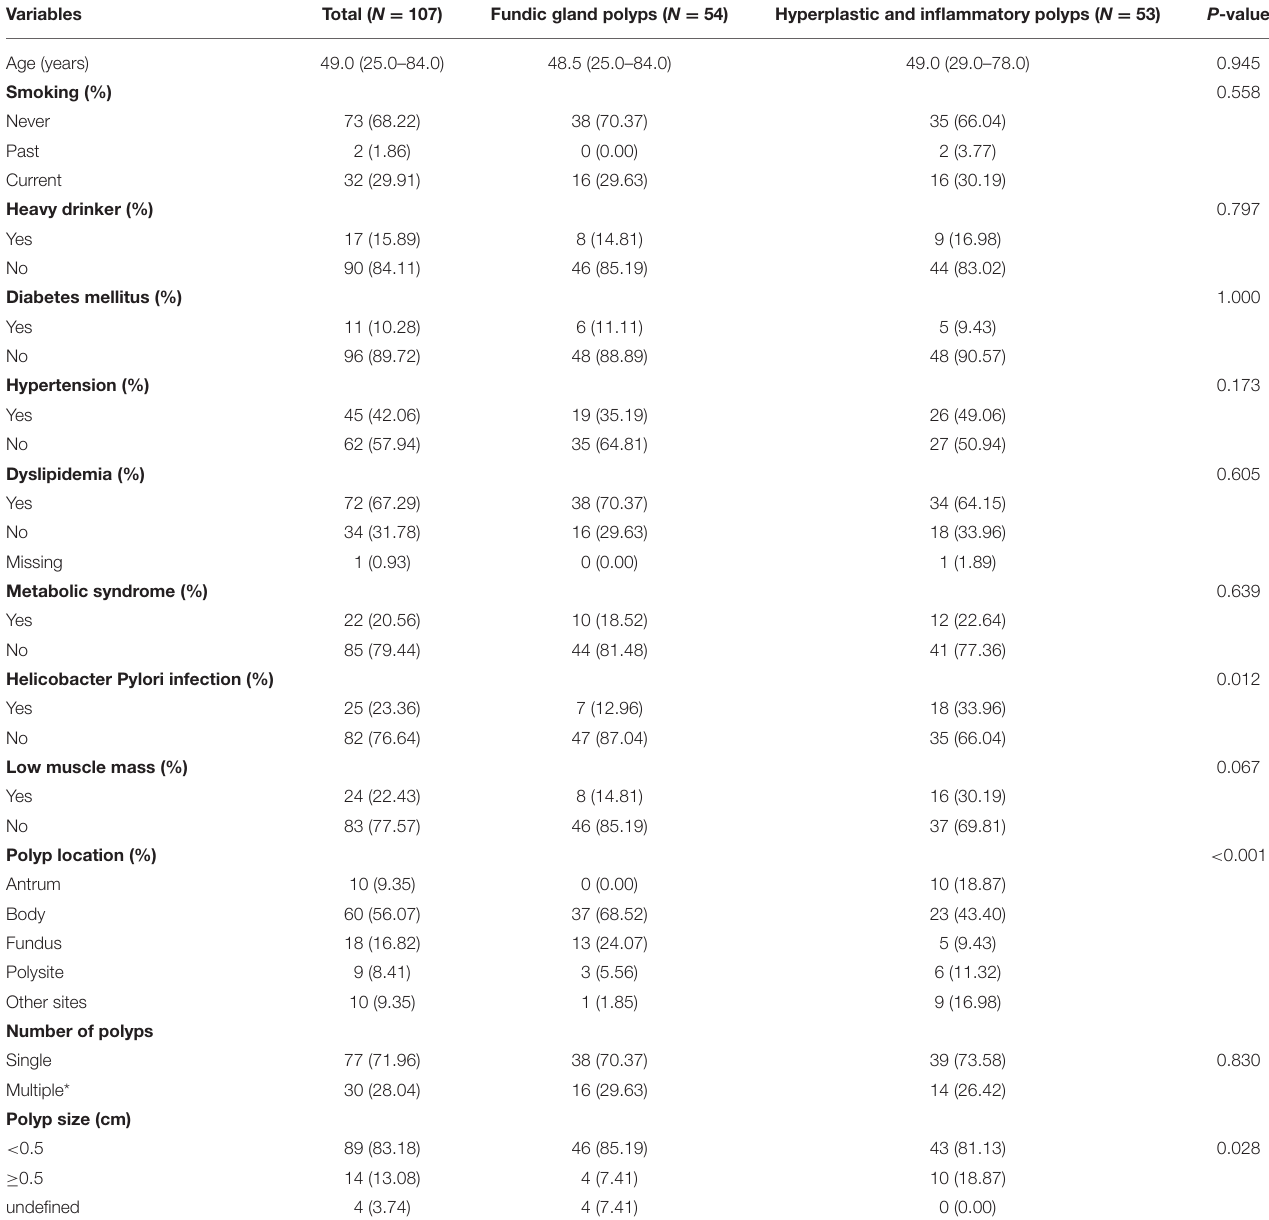
TABLE 2 | Baseline characteristics according to different pathological type of gastric polyps [median (range) or n (%)].